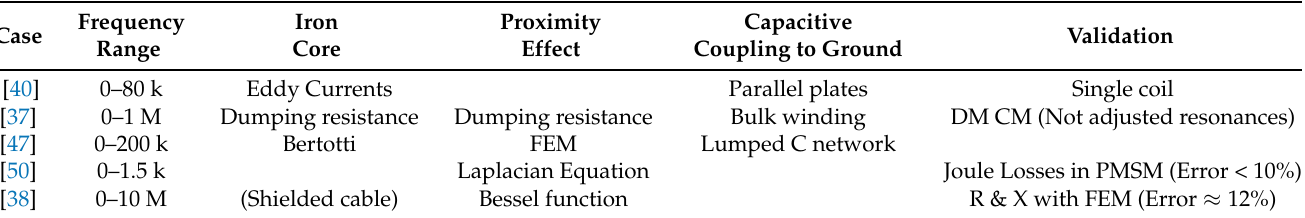
Table 3. Analytic simulation